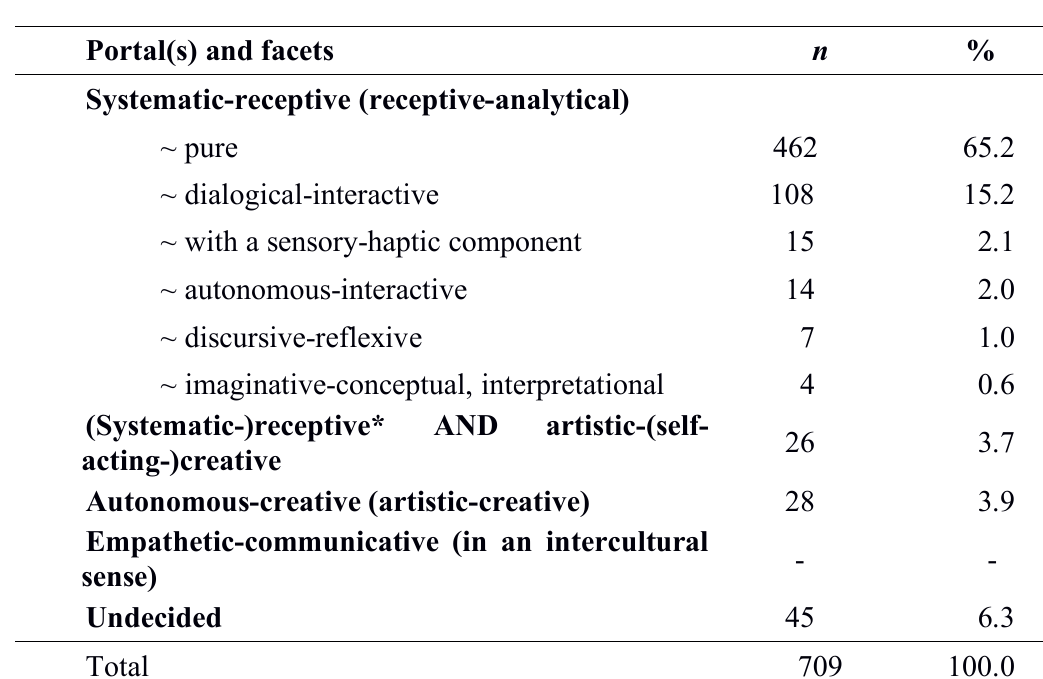
Table 2 . Frequency and percentage of the portals and their newly defined facets in the sample ( N =